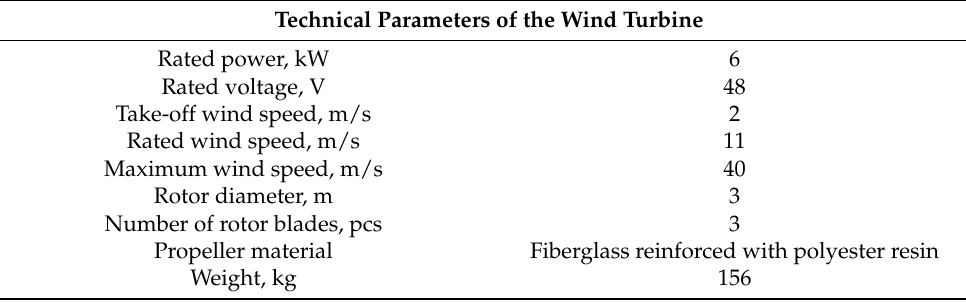
Number of rotor blades, pcs Propeller material Fiberglass reinforced with polyester resin Weight, kg